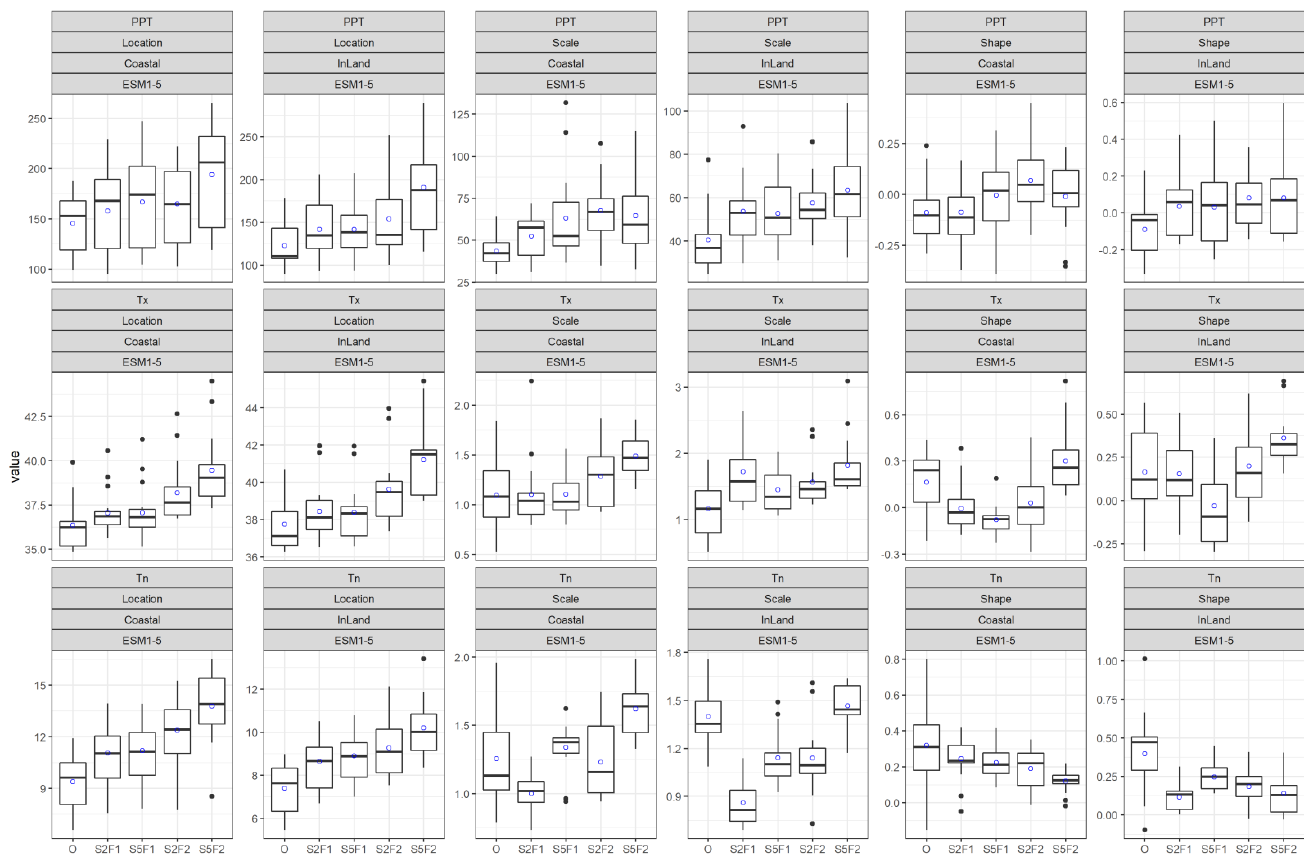
Figure 4. Box plots of fitted GEV parameters (Location, Scale and Shape) at observed (o) and future conditions (only data from GCM model, ESM1-5, is used for demonstration) for PPT, Tx and Tn for both coastal and inland region. Future scenarios were represented by ‘S245F1’, ‘S585F1’, ‘S245F2’ and ‘S585F2’, where S245 and S585, respectively, designate SSP245 and SSP585, and F1 and F2, respectively designate the near (2021–2060) and far future (2061–2100). The “blue circle” on each box plot represents the average